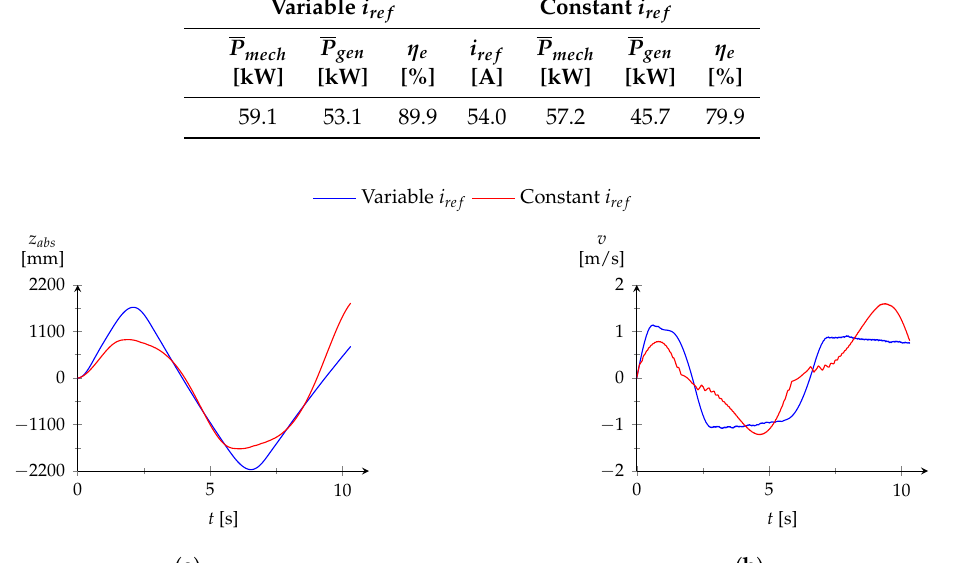
Table 3. Energetic conversion performance of the TLSRG with MPPT control and constant i ref control.